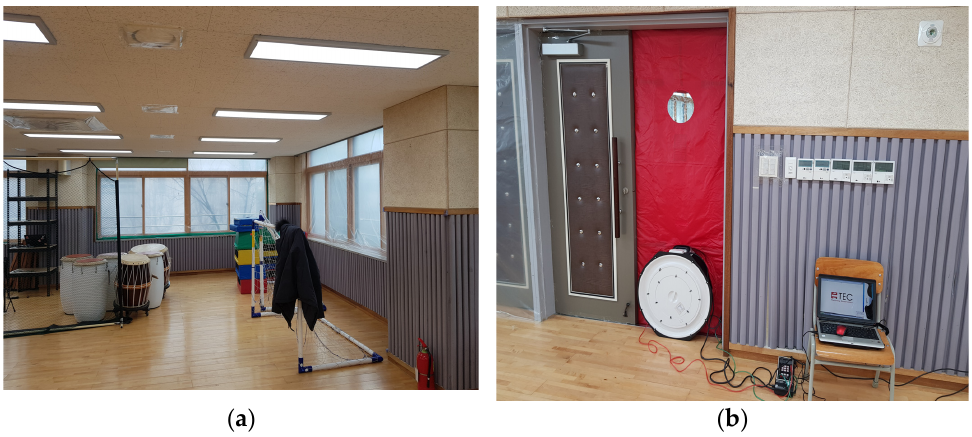
Figure 2. ( a ) Sealing of windows, doors, diffusers, air conditioners, and other openings before the blower door test; ( b ) blower door test of the MPA-space of D Elementary school.